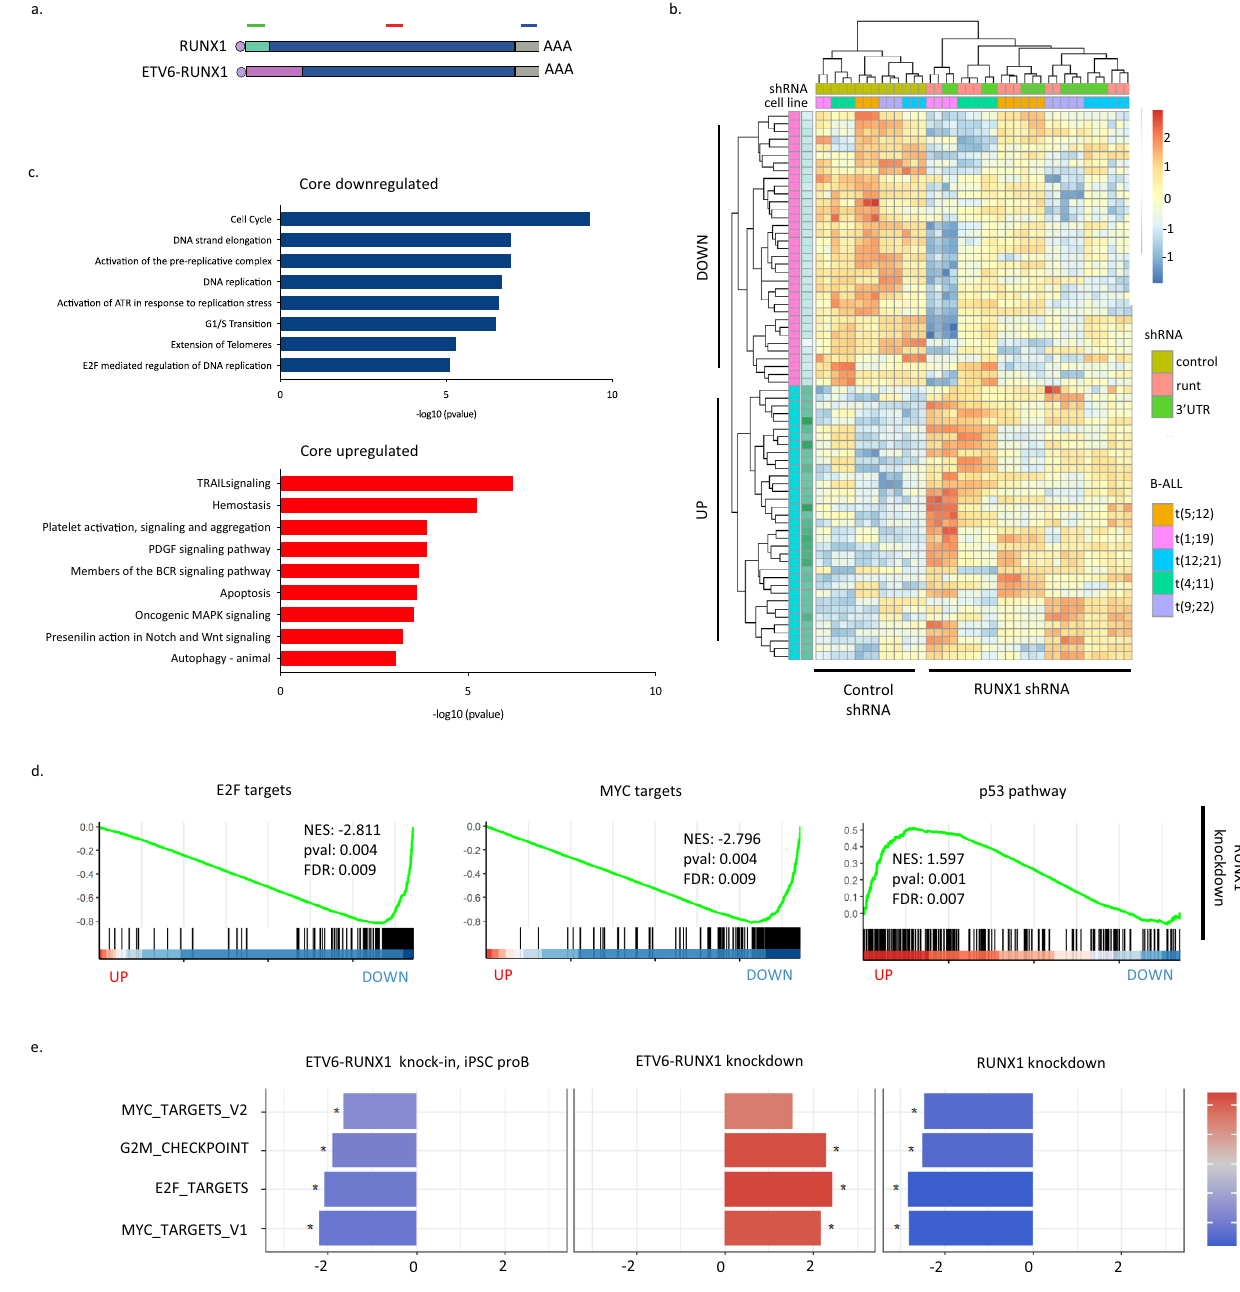
Fig. 5 | De fi ning a core RUNX1 program in B-ALL reveals antagonism between ETV6-RUNX1 and native RUNX1 in cell cycle regulation. a Schematic showing shRNAs targeting RUNX1 and/or ETV6-RUNX1. b Heatmap showing relative expression of the 25 most signi fi cantly up- or down-regulated genes following RUNX1 knockdown across fi ve B-ALL cell lines. c Bar plots showing signi fi cantly enriched GO-terms in the “ core ” up- or downregulated genes. d Plots of GSEA